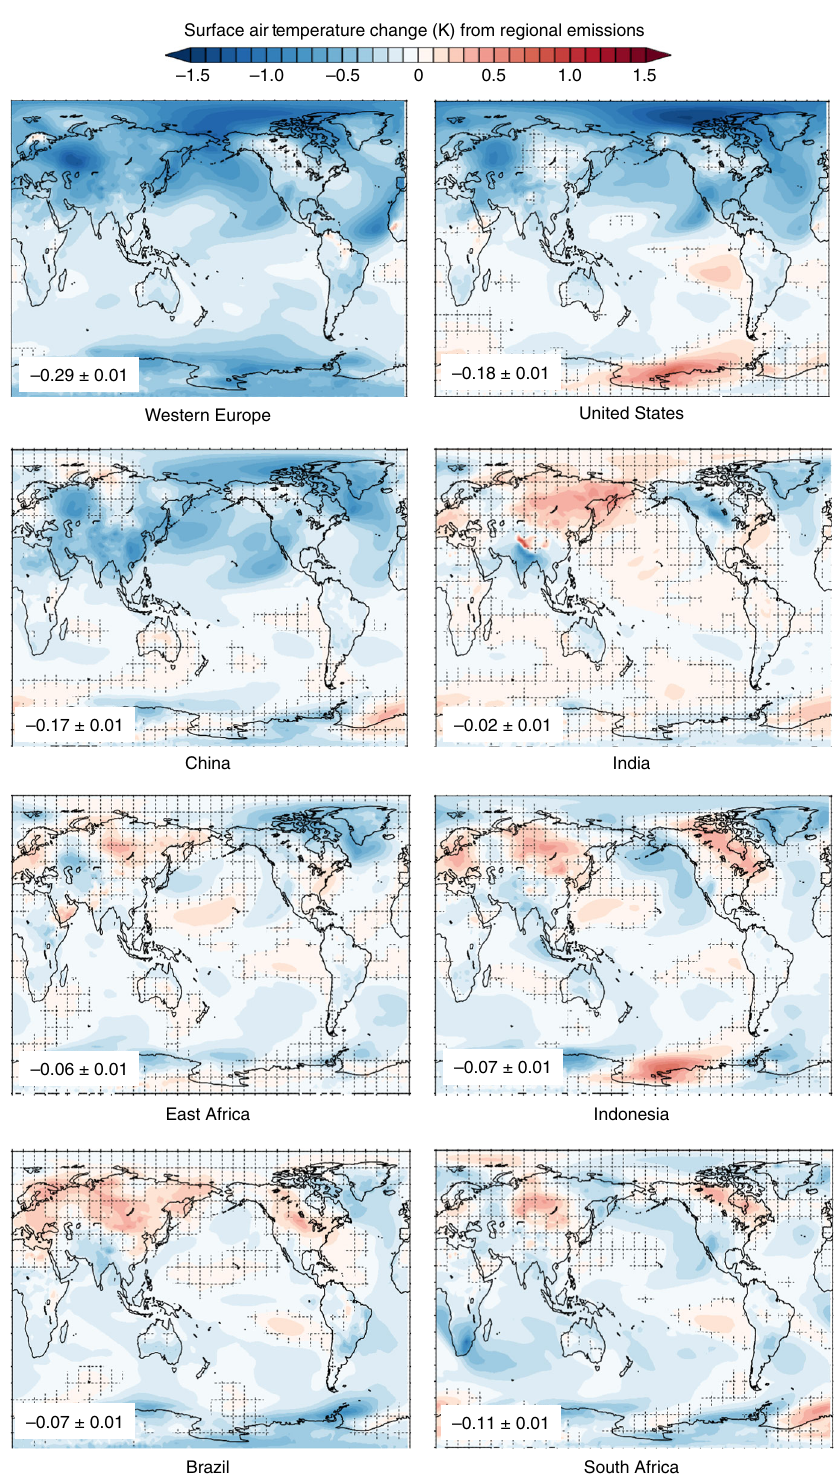
Fig. 2 Patterns of surface air temperature response to identical aerosol emissions from eight regions. Spatial patterns of surface air temperature change in response to identical aerosol emission in each the eight regions are shown. Global mean temperature change (K) with standard error is shown in bottom left. Grid markings indicate regions that are not statistically signi fi cant at the 95% con fi dence level via t